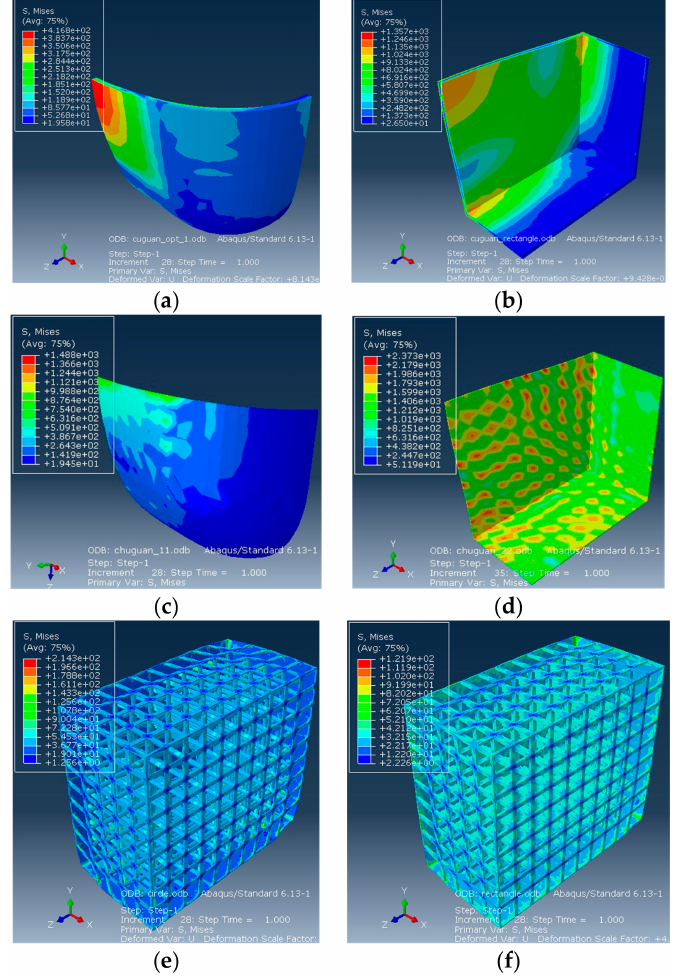
Figure 6. Stress analysis figure for ( a ) the conventional storage tank (wall thickness: 2.1 mm), ( b ) the cuboid storage tank (wall thickness: 2.1 mm), ( c ) the conventional storage tank (wall thickness: 0.5 mm), ( d ) the cuboid storage tank (wall thickness: 0.5 mm), ( e ) the improved storage tank with a circular column structure, and ( f ) the improved storage tank with a square column